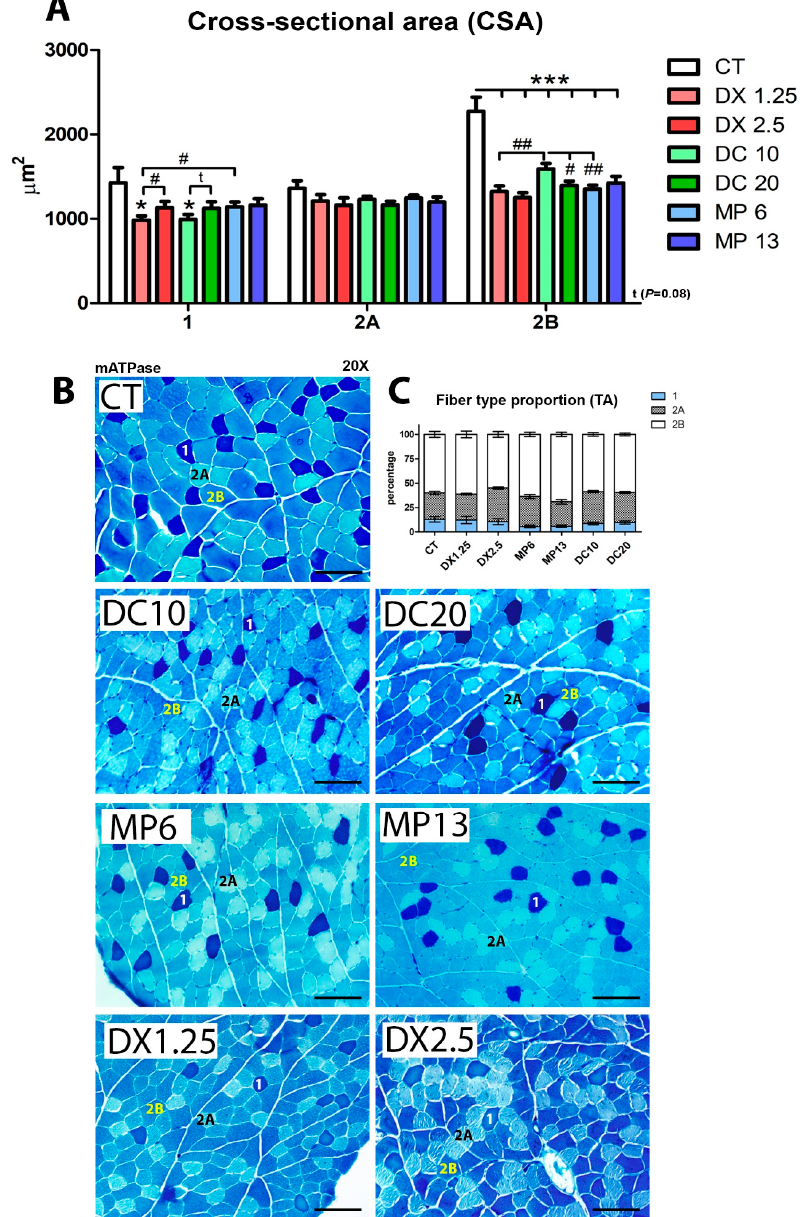
Figure2. Musclecross-sectionalareaandmusclefibertypeproportionsanalyzedaftertheadministration Figure 2. Muscle cross-sectional area and muscle fiber type proportions analyzed after the administration of different glucocorticoids. ( A ) Cross-sectional area—(*) represents statistical of di ff erent glucocorticoids. ( A ) Cross-sectional area—(*) represents statistical di ff erence in comparison to the control group (CT), and (#) represents statistical di ff erence between two groups. Legend: * or # = P < 0.05; ## = P < 0.01 and *** = P < 0.001 ( n per group: CT = 10, DX1.25 = 9, DX2.5 = 8, DC10 = 10, DC20 = 10, MP13 = 8, MP6 = 8). One-way ANOVA, followed by the Bonferroni post hoc test, was used for each fiber type analysis; ( B ) histological mATPase photographs, scale bar = 100 µ m; ( C ) muscle fiber type proportions (statistical analysis is expressed in Table